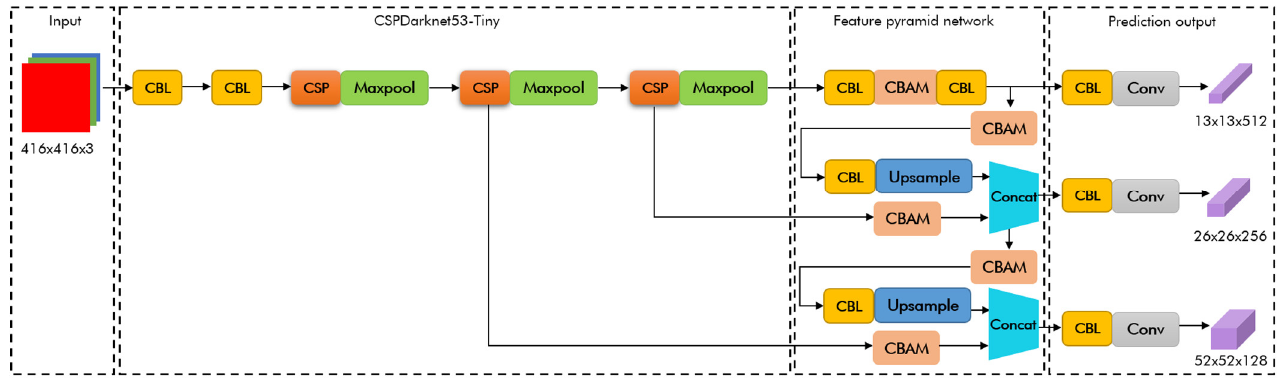
Figure 6. The network structure of the algorithm in this paper.